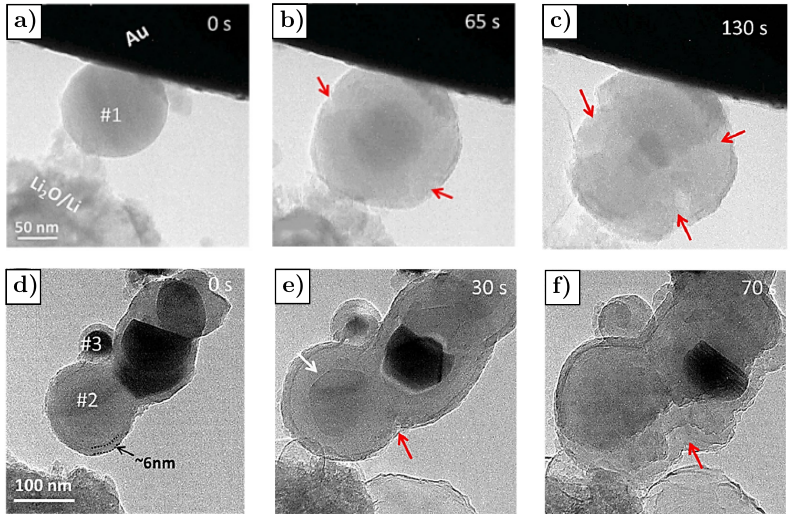
Figure 10. Lithiation of ( a – c ) uncoated silicon particle and ( d – f ) coated silicon particles. The time value depicted in the figure refers to the lithiation time. Reprinted with permission by Elsevier from [68], Copyright